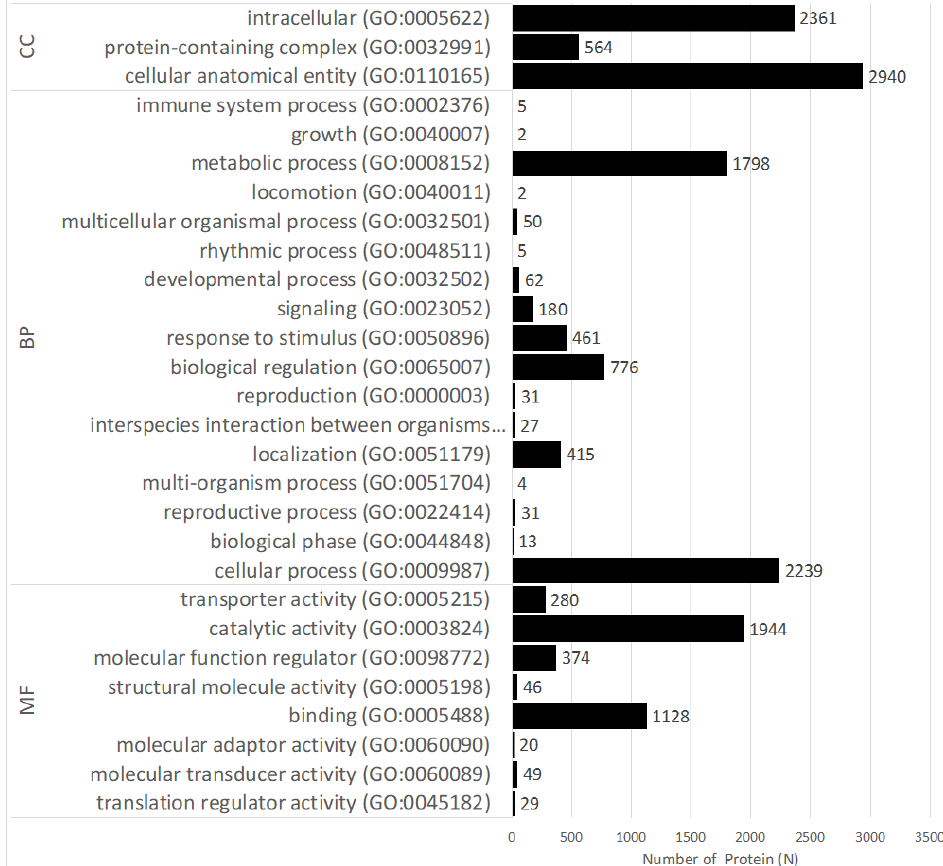
Figure 4. Gene ontology analysis of total differentially expressed genes. GO terms from differentially expressed genes were identified in all the conditions obtained by Panther Analysis.